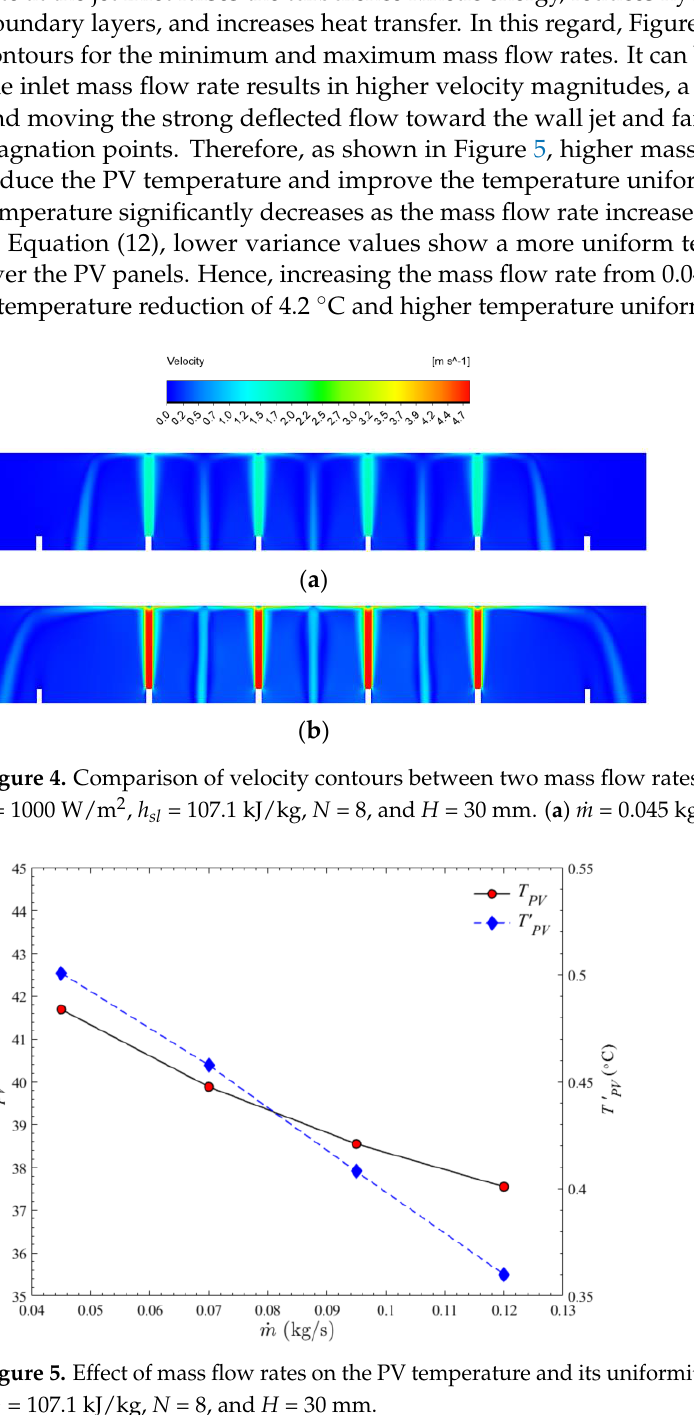
Figure 3. Effect of solar irradiation and latent heat on the PV temperature at c = 2%, ṁ = 0.045 kg/s, N = 8, and H = 30 mm.